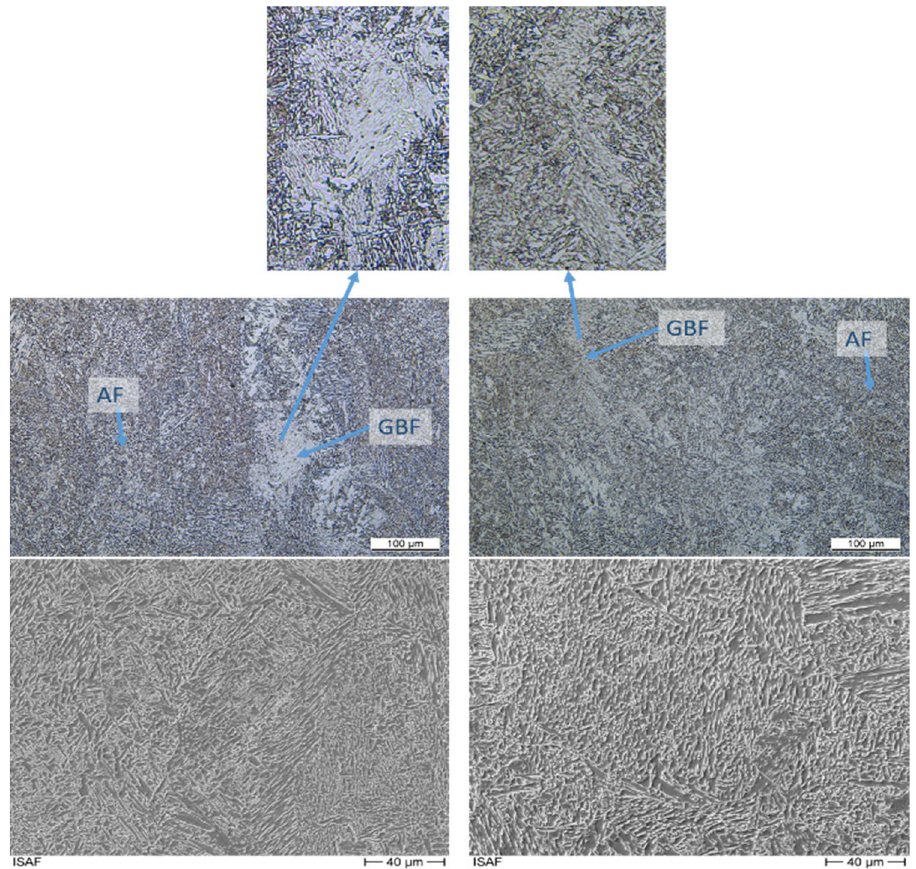
Figure 11. Microstructure. Left side: 500A 30 V 2 bar, right-side: 500A 35 V 9 bar.